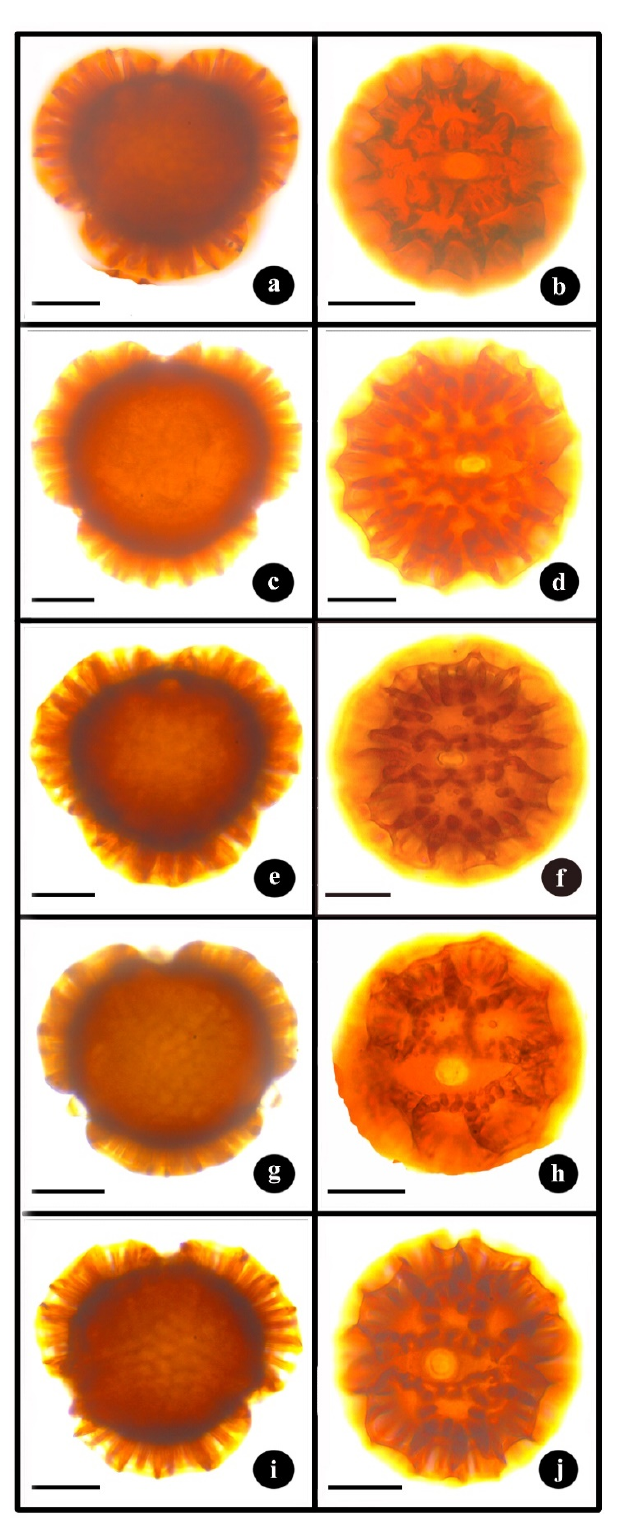
Figure 3. Light photomicrographs of Barleria cristata morphotypes ( a – j ). polar view ( a , c , e , g , i ), aperture view ( b , d , f , h , j ). ( a , b ) B. cristata (cultivated form 1); ( c , d ) B. cristata (cultivated form 2); ( e , f ) B. cristata (cultivated form 3); ( g , h ) B. cristata (Nandi Hills); ( i , j ) B. cristata (Uttarakhand). Scale bars ( a – j ) = 50 µm.